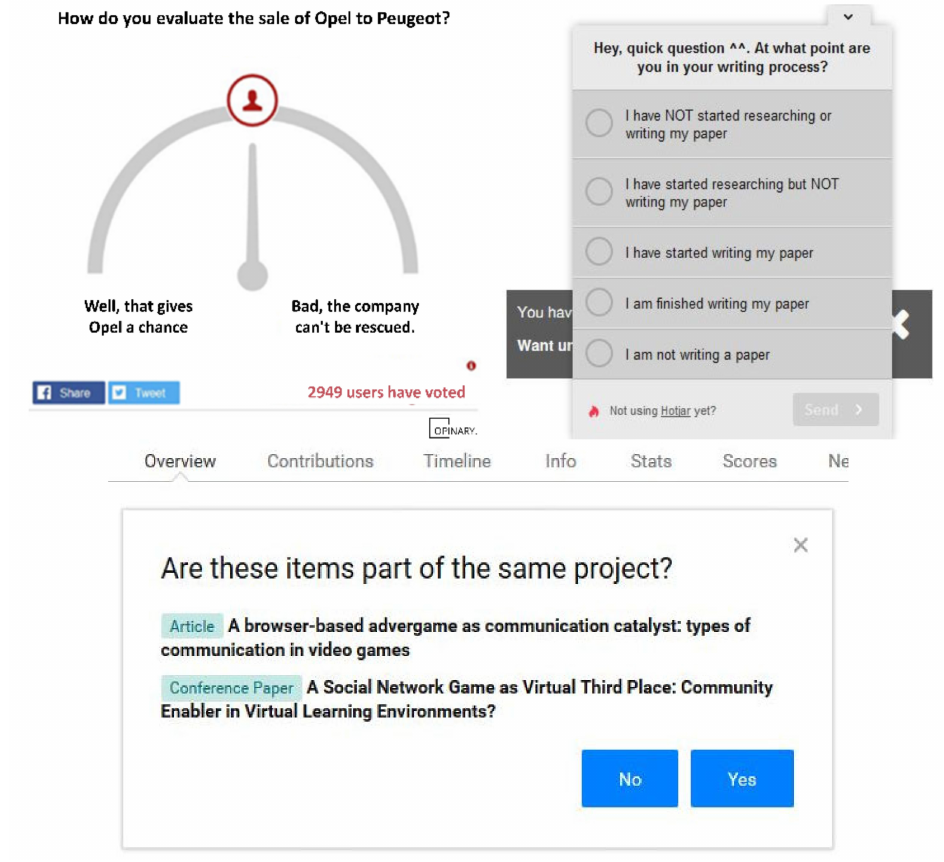
Figure 2. EI examples: Top left: request for seamless personal evaluation of a company takeover [58,59]; top right: slide-in single choice question for the reason of web page visit [60]; bottom: in-passing request for additional attributes of content in a domain-specific content manage- ment system [61]. Table 1. EI Schema